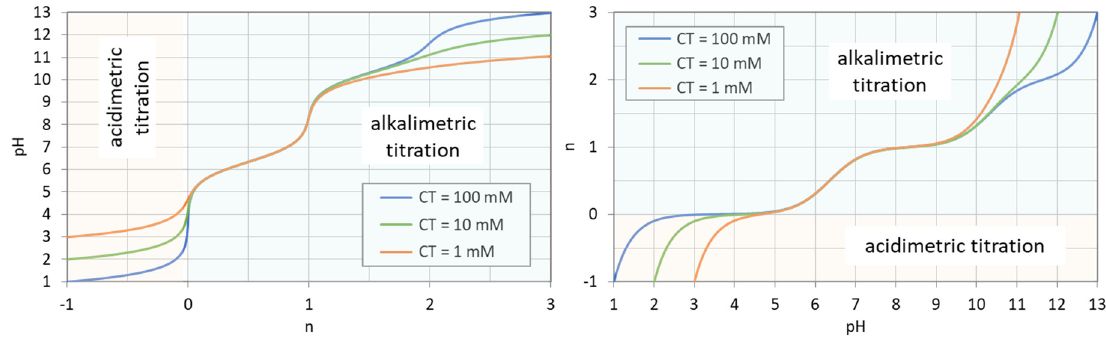
Figure 8. Titration curves for 1, 10, and 100 mM H 2 CO 3 . ( Left ): n = n(pH); ( right ): pH = pH(n).